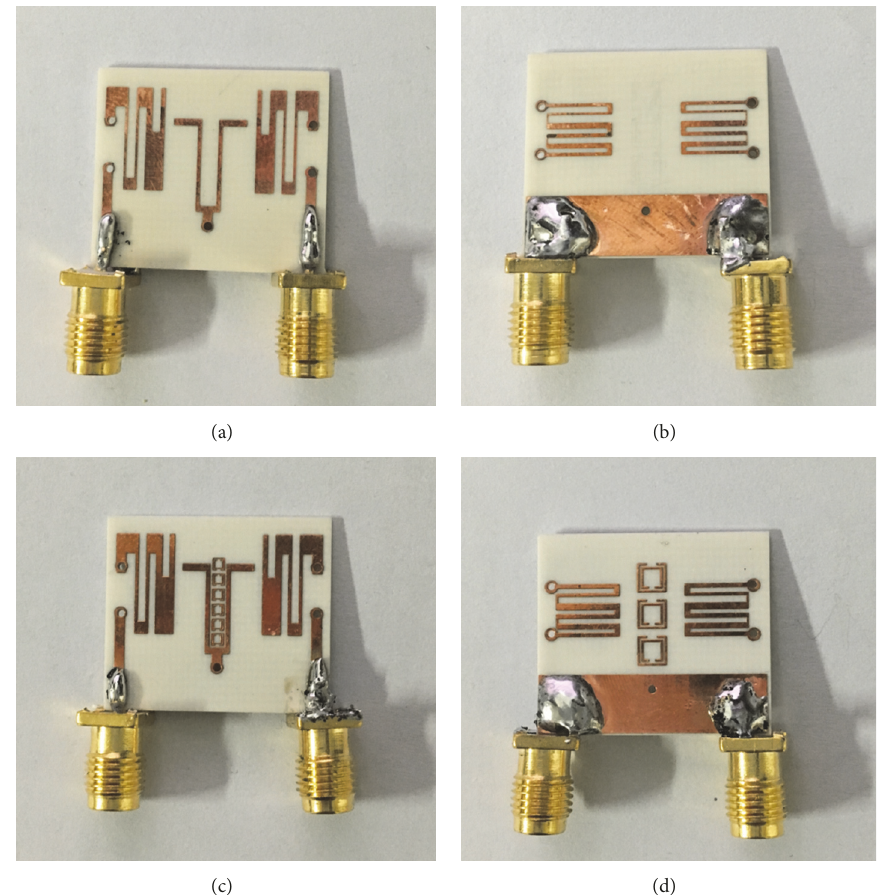
Figure 2: Fabricated prototype of the MIMO antennas. (a) The top of original antenna, (b) the bottom of original antenna, (c) the top of the decoupling antenna, and (d) the bottom of the decoupling